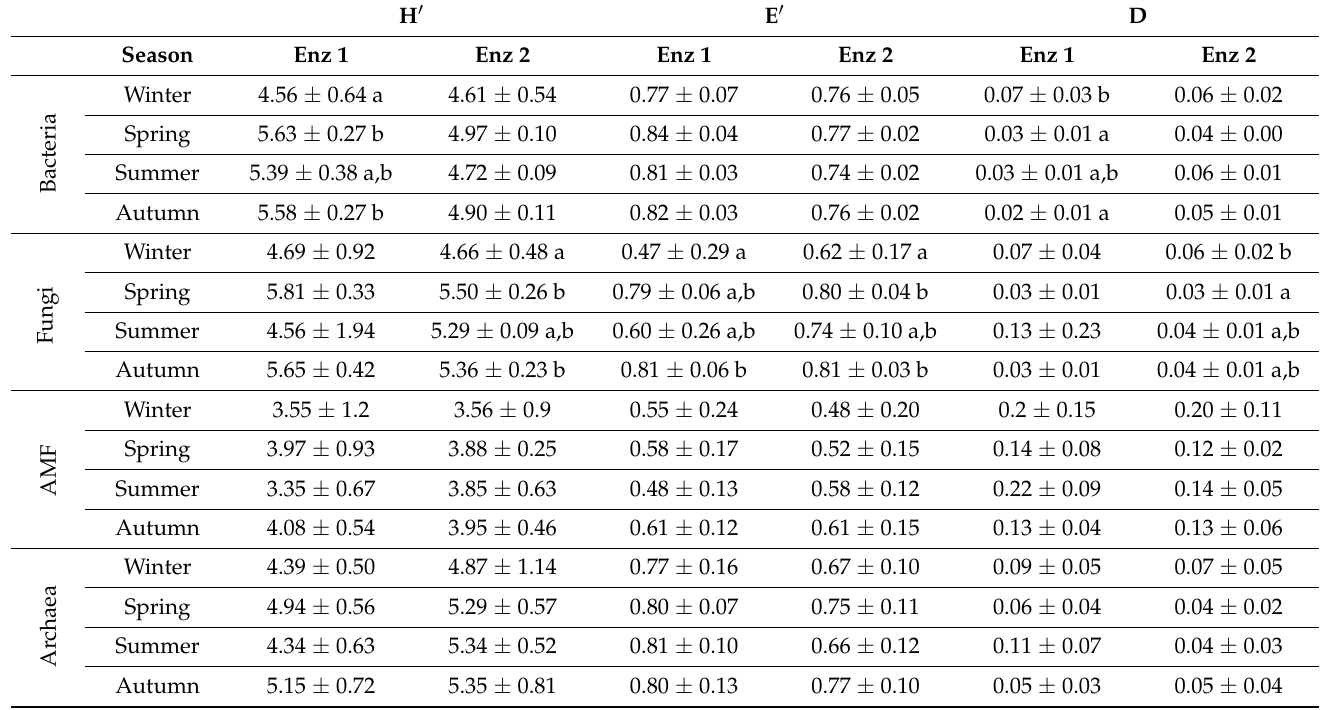
Table 4. Shannon–Winner diversity (H (cid:48) ), Corrected Evenness (E (cid:48) ), and Simpson index (D) of the four microorganisms’ groups, according to